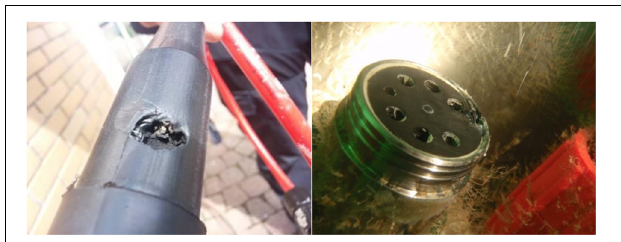
FIGURE 11 | Underwater plug and respective socket of the 1000 V power input circuit after severe damage. Photos: P.